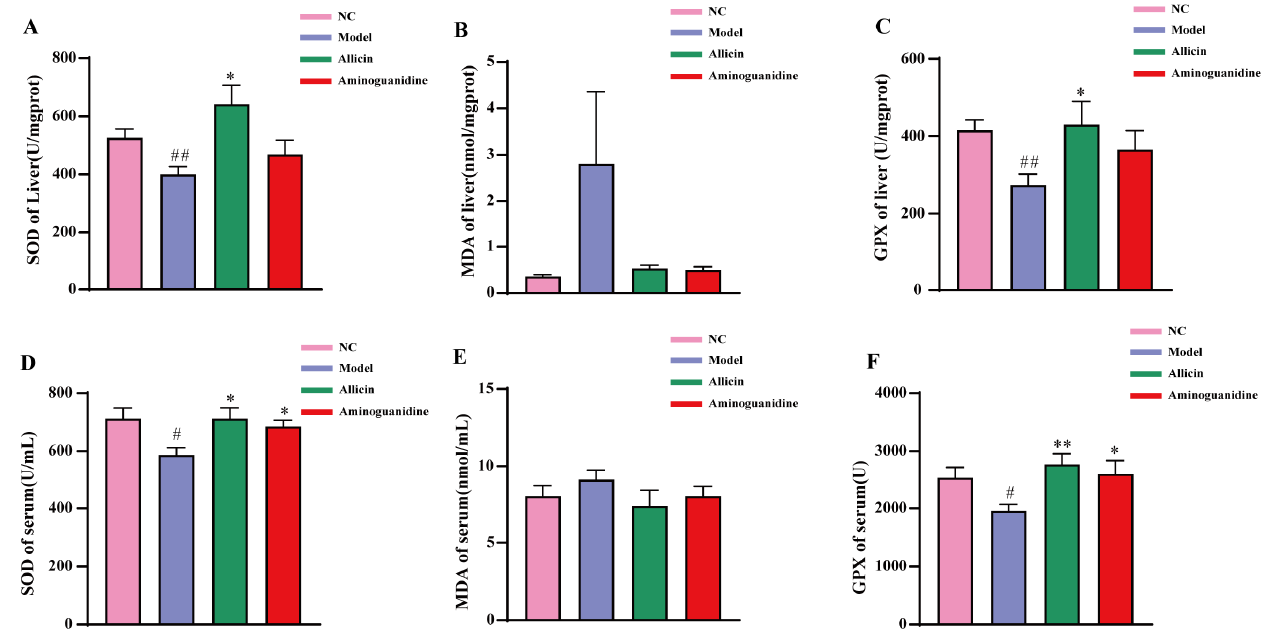
Figure 4. Results of serum and liver SOD, MDA, and GSH-PX measurements. The drugs were administered at the end of the 7th week of the experiment, with a 6-week dosing cycle. The experiment ended at the 13th week, and the rats were sacrificed at the same time. ( A – C ) SOD, MDA, and GSH-PX in the liver; ( D – F ) SOD, MDA, and GSH-PX in the serum. “#” represents the comparison with the NC; “*” represents the comparison with the model group ( ## p < 0.01, # p < 0.05, ** p < 0.01, and * p < 0.05). The horizontal axes in Figures 3A, 3B, 3D and 3E represent the NC, Model, Allicin and Aminoguanidine group respectively from left to right.